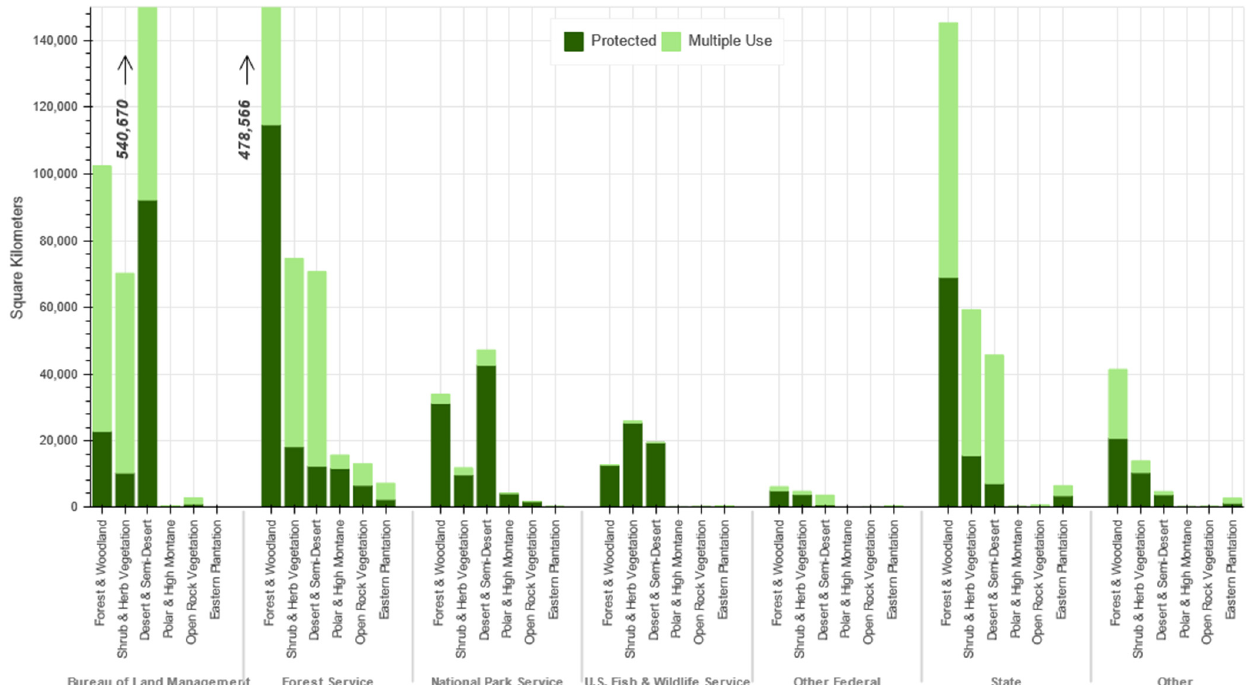
Figure 5. Total area based on converting the mapped pixel count to area for each USNVC Class under management by federal, state, and other agencies. Ruderal types are included in the totals. The Eastern North American Temperate Forest Plantation (Eastern Plantation) from the cultural vegetation hierarchy are included as a separate bar. The category Other Federal includes agency lands such as Bureau of Reclamation, Department of Defense and Department of Energy. Other includes a variety of management such as American Indian Areas (Tribal lands), Non-Governmental Organization, Private, and local Agency lands.